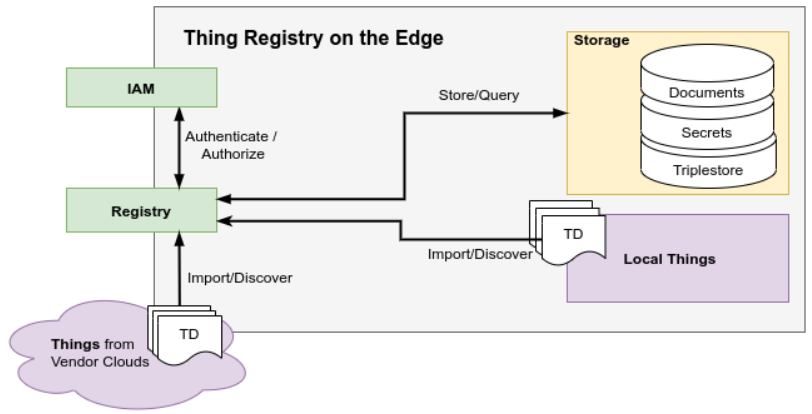
Figure 2. Architecture of the